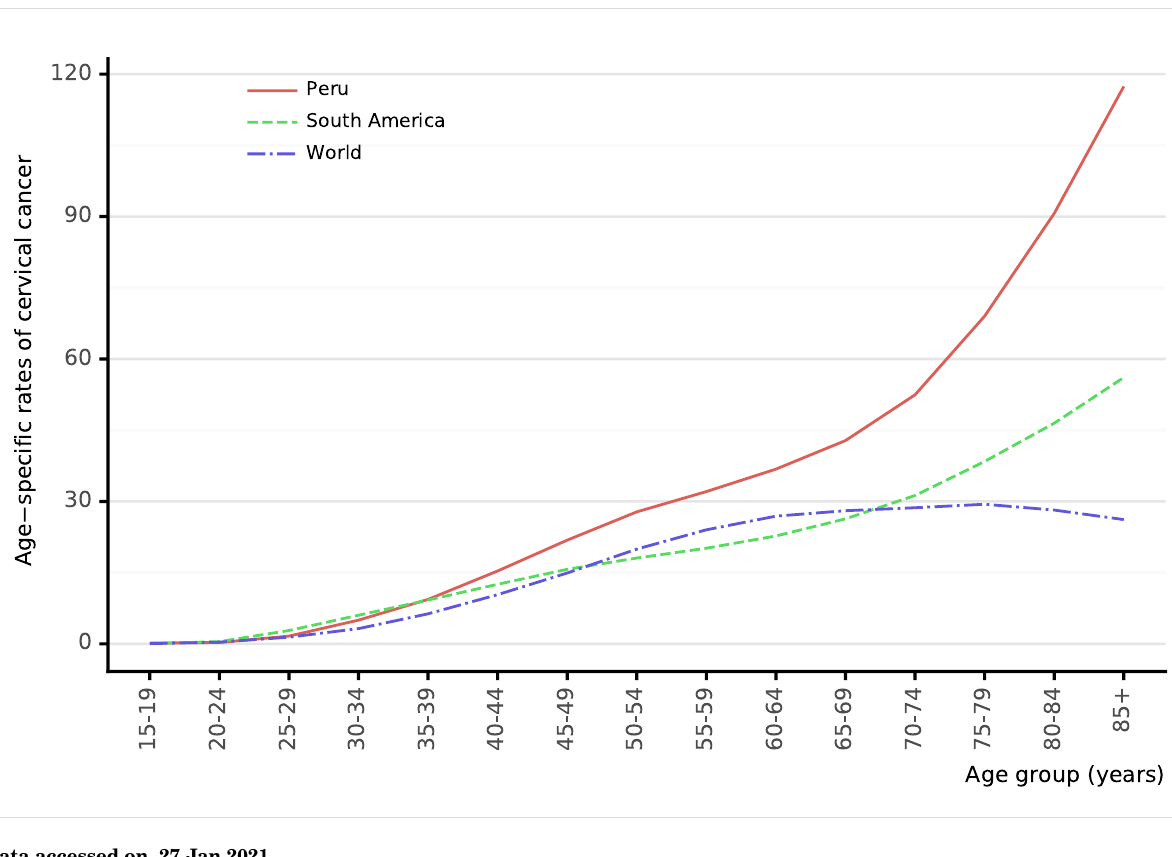
Figure 107: Comparison of age-specific cervical cancer mortality rates in Peru, within the region, and the rest of